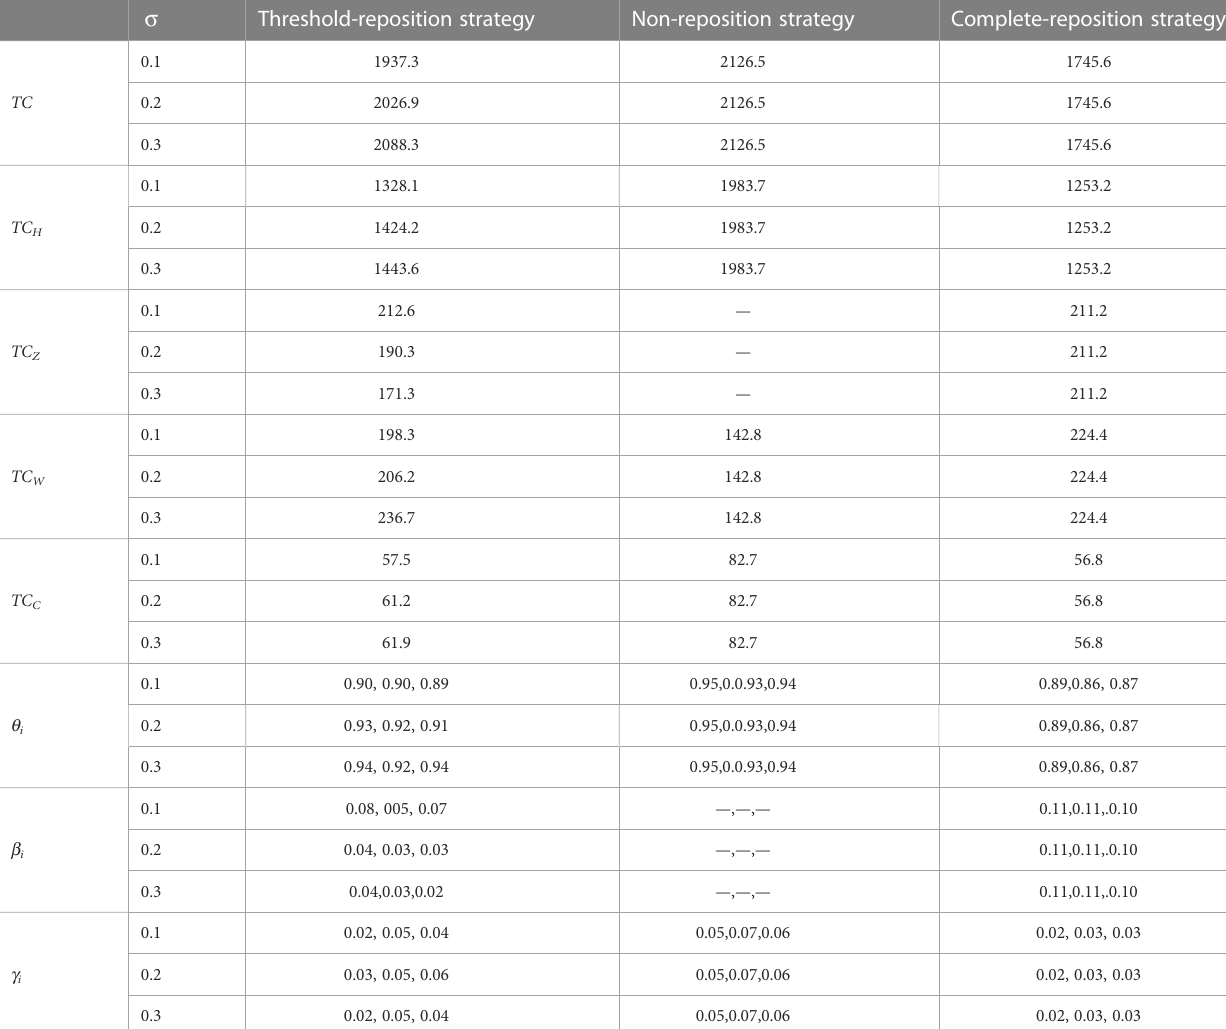
TABLE 5 Analysis of the in fl uence of s ‘ s change on three strategies.